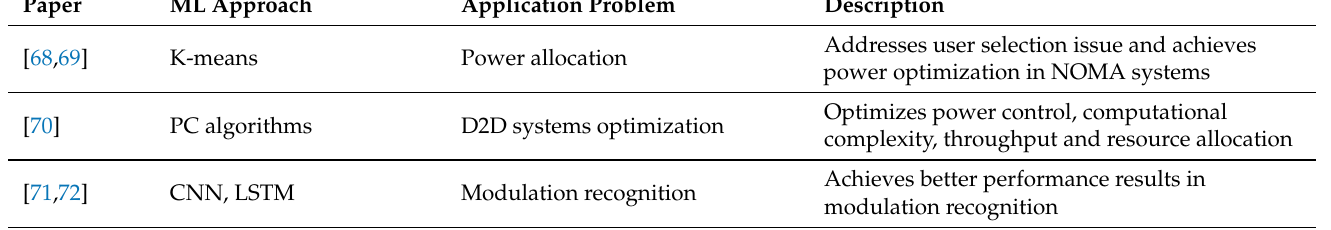
Table 7. Unsupervised ML models in 6G